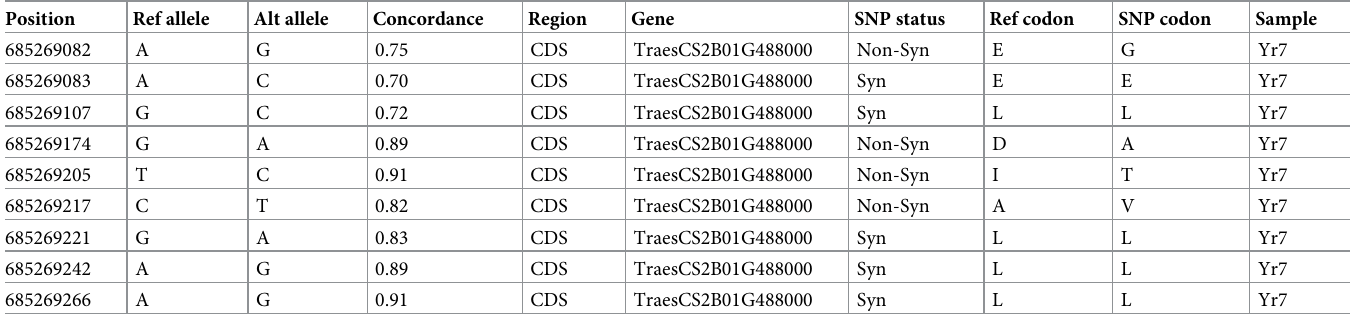
Table 3. Annotation of Cadenza specific alleles that are homozygous in the Yr7